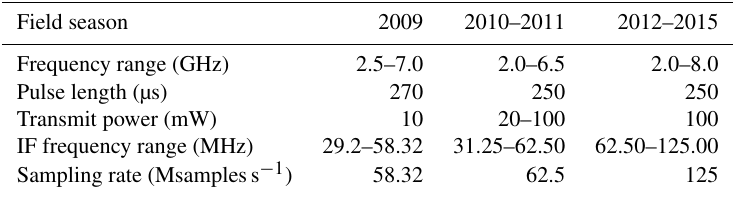
Table 1. Radar parameter used in Arctic